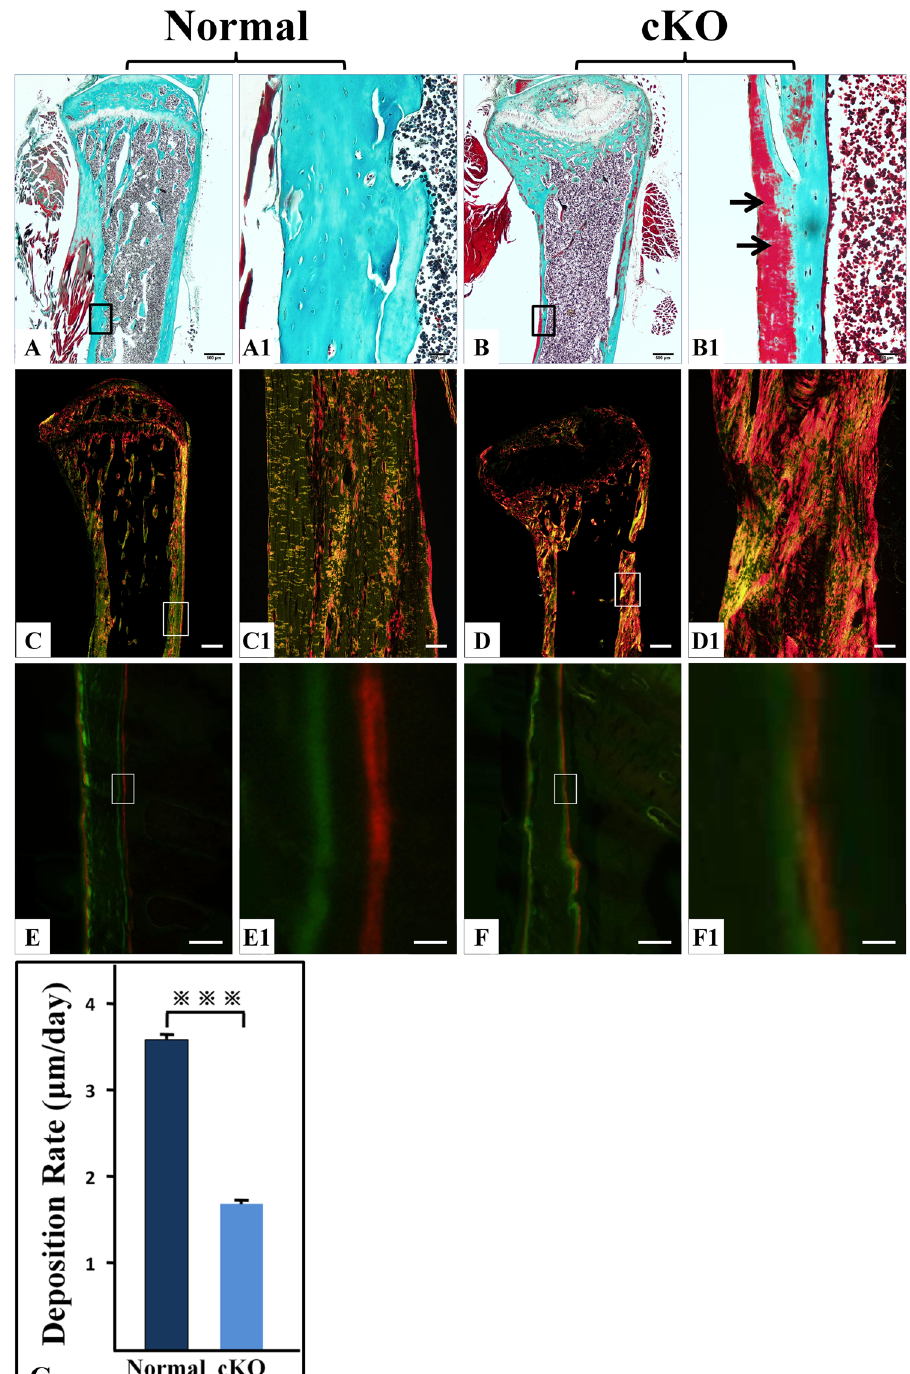
Figure 4. Goldner’s Masson trichrome staining, picro-sirius red staining, and double fluorochrome labeling. ( A – B1 ) Goldner’s Masson trichrome staining of tibias from 12-week-old mice. ( C – D1 ) picro-sirius red staining of tibias from 12-week-old mice. ( E – F1 ) double fluorochrome labeling of femurs from 4-week-old mice. ( G ) quantitative analyses of data acquired from the double fluorochrome labeling specimens from five mice (n = 5); *** P < 0.001. ( A1 , B1 , C1 , D1 , E1 and F1 ) were the higher magnification views of the box areas in ( A , B , C , D , E and F ), respectively. Bars in ( A , B , C and D ) 500 µ m; bars in ( A1 , B1 , C1 and D1 ) 50 µ m; bars in ( E and F ) 100 µ m; bars in ( E1 and F1 ) 10 µ m. Goldner’s Masson trichrome staining of tibias in 12-week-old normal ( A , A1 ) and cKO mice ( B , B 1) showed that the cKO mouse bone had large areas stained red, indicating an accumulation of osteoid in the Fam20C -deficient bone (arrows in B1 ). Compared to the 12-week-old normal mice ( C , C1 ), the collagen fibers in the femoral cortical bone of the cKO mice ( D , D1 ) appeared disorganized and thicker. The changes in the double fluorochrome labeling appeared to be mainly in the endosteal region of femurs in the 4-week-old cKO mice ( F , F1